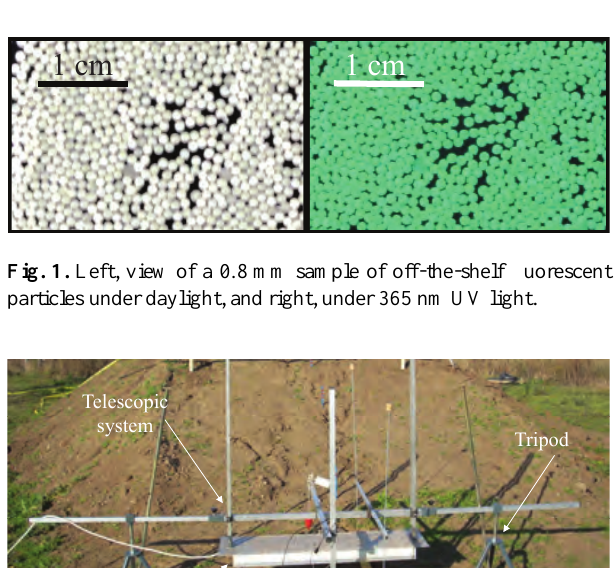
Fig. 3. View of the experimental site depicting the particle detection apparatus and the rainfall simulator.